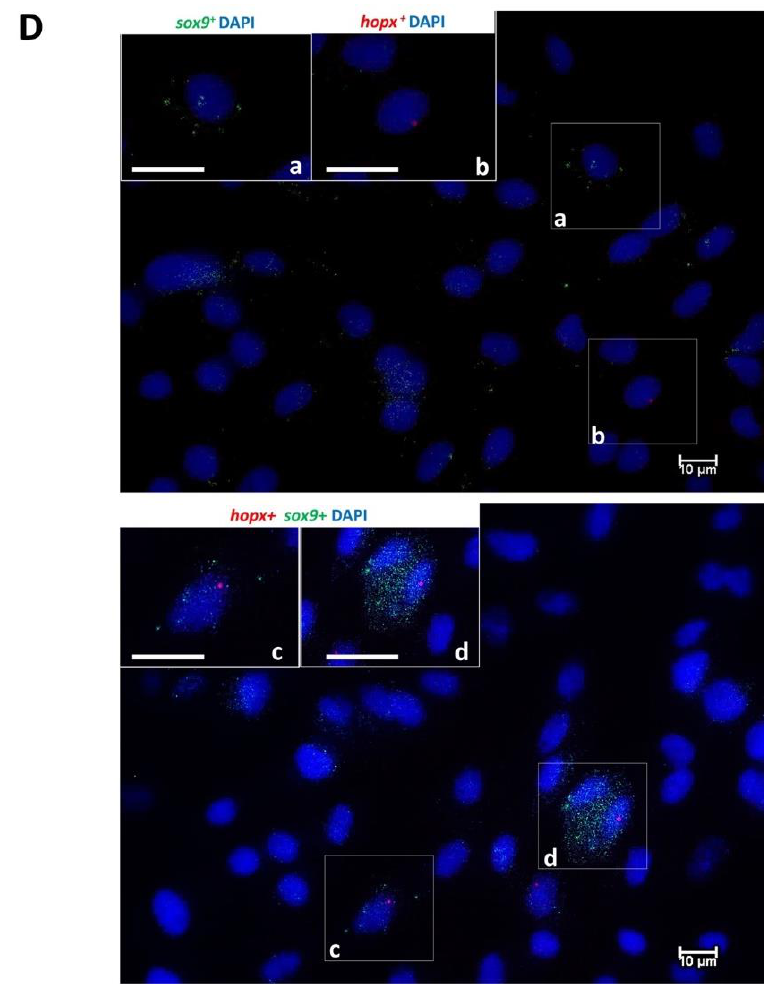
Figure 4. Effect of seeding density on sox9 and hopx expression rate. ( A ) sox9 + /hopx * cell rates at low and high seeding densities relative to total cell count (top). Data are shown as the mean ± SD of 3 independent experiments. ( B ) sox9+ cell rate at low (blue bars) and high (red bars) seeding densities relative to epithelial cells ( ppib + cells, bottom). Data are shown as the mean ± SD of 3 independent experiments. ( C ) sox9 h-score of RTpi-MI, RTdi-MI and RTgutGC at low and high seeding density. Data are shown as the mean ± SD of 3 independent experiments. Different superscript letters indicate statistical significance. ( D ) Representative microphotographs of cells only positive for either sox9 or hopx (a,b) or both sox9 and hopx (c,d). Scale bar, 10 µm.